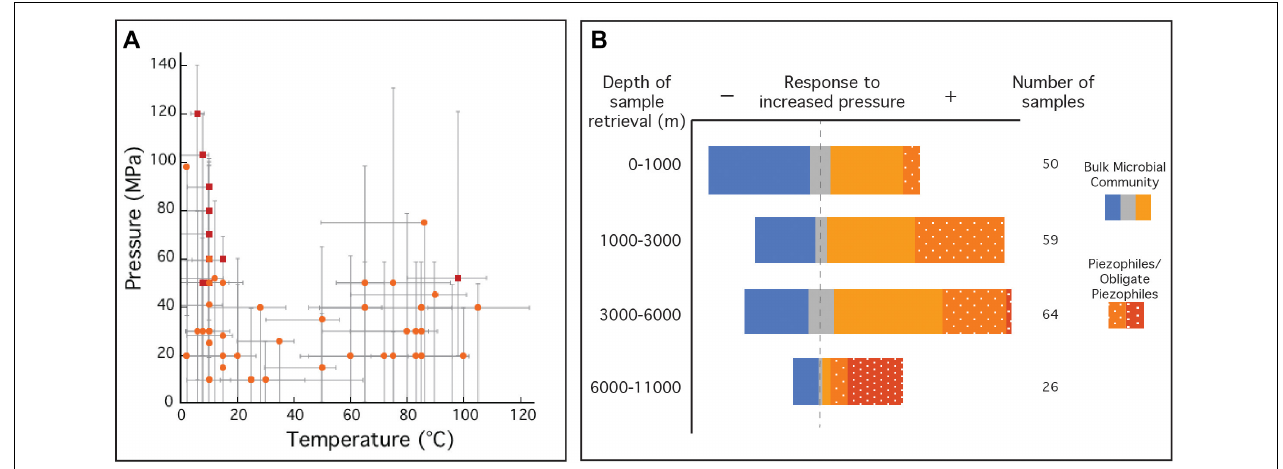
FIGURE 1 | (A) Optimal temperature and pressure growth conditions for known piezophiles (light orange circles) and obligate piezophiles (red squares). Gray bars indicate the reported temperature and pressure growth ranges for each isolate. (B) Collection of natural samples and isolates with sample origins at various depths and their response to elevated pressure compared to ambient pressure (0.1 MPa). Natural samples (solid), where metabolic activity was monitored, was reported to have either a negative (solid blue), neutral (solid gray) or positive (solid orange) response to increased pressure compared to growth at 0.1 MPa. Isolated piezophiles (dotted orange) are described here as having optimum growth at pressures above 0.1 MPa and obligate piezophiles (dotted red) are those that require elevated pressures for growth and cannot grow at 0.1 MPa. This figure is not an exhaustive list of all natural samples taken from the deep biosphere with reported pressure tolerances and does not include piezotolerant organisms (optimum growth pressure at 0.1 MPa). Temperature and pressure data for isolates in A , B were collected from references listed in Supplementary Table S2 . Data for natural samples were extracted from Picard and Daniel